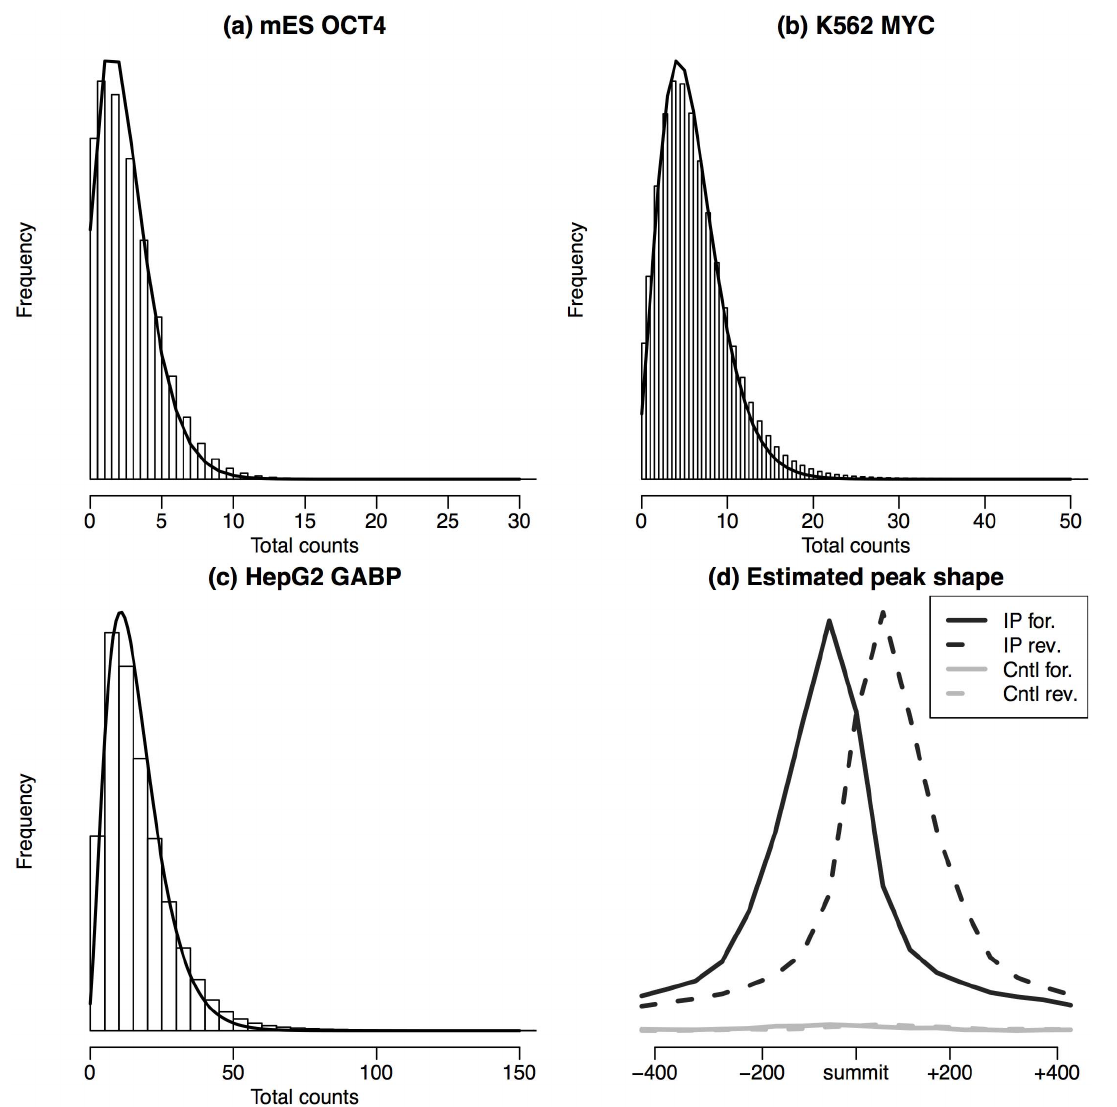
Figure 2. (a)–(c): histogram of total read counts in background regions from different datasets: (a) TF OCT4 in mouse ES cells; (b) TF MYC in K562 cell line; and (c) TF GABP in HepG2 cell line. The black solid curve is the theoretical density for the negative binomial distribution with parameters estimated from the method of moment procedure. It can be seen that the total counts in background regions can be approximated well by a negative binomial distribution, and the method of moments for estimating negative binomial parameters works well. (d) Estimated peak shape from polyaPeak for K562 MYC data.